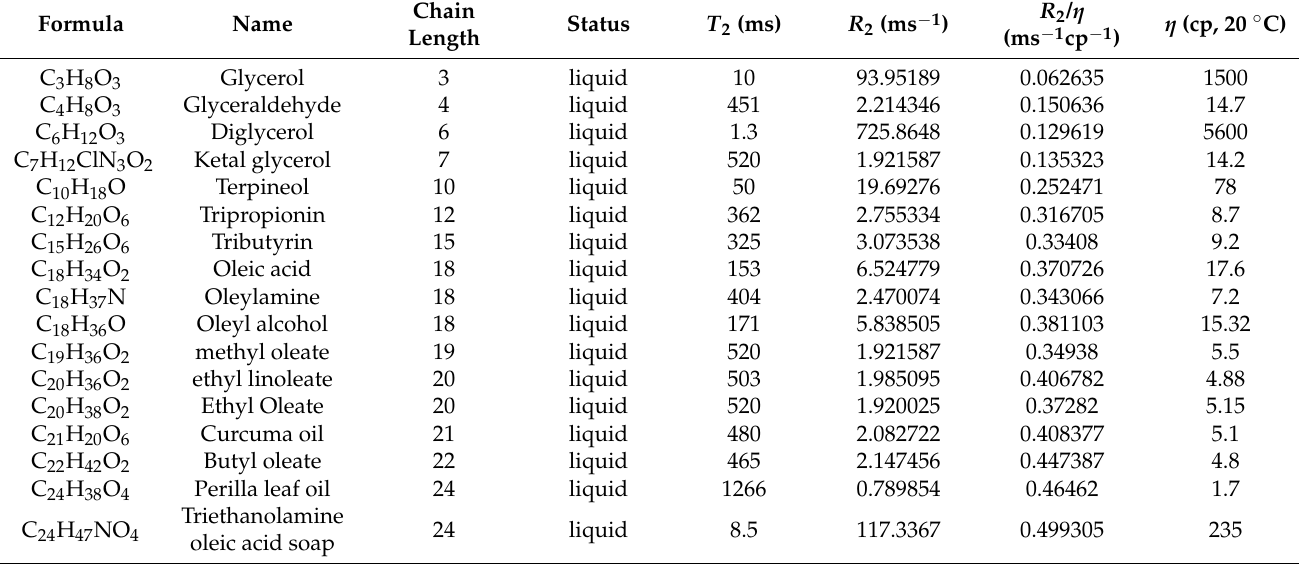
Table 1. Experimental values of carbon chain length and spin–spin relaxation rate of